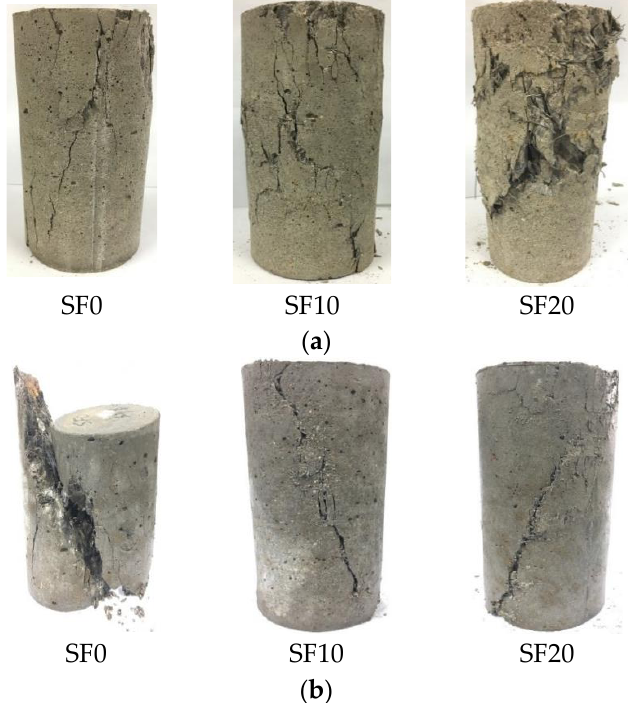
Figure 16. Typical failure modes of SFRC specimen under different confining pressures: ( a ) 0 and ( b ) 5 MPa.